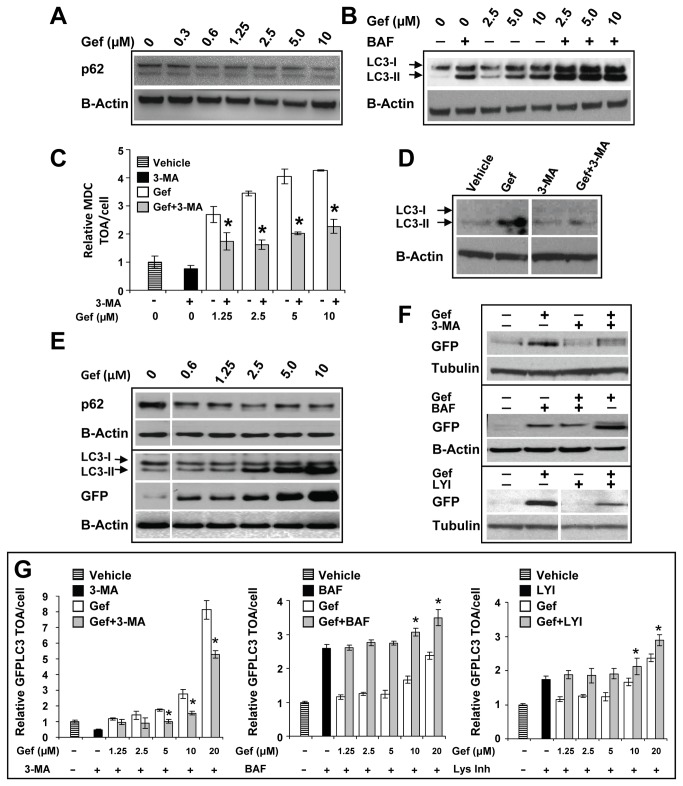
Gefitinib induces autophagic flux.(A - D) Autophagic flux assays performed in SKBR3 cells. (A) Western blot analysis of p62 expression in lysates derived from cells treated for 3 h with vehicle (0 µM gefitinib) or increasing concentrations of gefitinib (Gef) (B) Western blot analysis of LC3 levels in lysates derived from cells treated for 3 h with increasing concentrations of gefitinib in the absence or presence of 5 nM bafilomycin A1 (BAF). (C) HCA of TOA in cells treated for 72 h with increasing concentrations of gefitinib in the absence or presence of 10 mM 3-MA added for the last 3 h of treatment. The results are normalized to the vehicle control expressed as 1. Each bar represents the mean±SD from 3 replicate wells. Asterisks indicate statistically significant differences (p<0.05) between cells treated with gefitinib or 3-MA alone and cells treated with 3-MA in the presence of gefitinib. The results shown are representative of two experiments. (D) Western blot analysis of LC3-I and LC3-II levels in lysates derived from cells treated for 24 h with vehicle, 5 µM gefitinib, 5 mM 3-MA and the combination of gefitinib and 3-MA at the corresponding concentrations. Representative blots in (A), (B) and (D) are shown. (E - G) Autophagic flux assays performed in MCF7-GFPLC3 cells. (E) Western blot analysis of autophagic markers in lysates derived from cells treated for 18 h with increasing concentrations of gefitinib. Cleaved GFP is marked as GFP. (F) Western blot analysis of cleaved GFP levels in lysates derived from cells treated with vehicle or 10 µM gefitinib in the absence or presence of 10 mM 3-MA for 3 h (top panel), in the absence or presence of 50 nM bafilomycin A1 (BAF) for 24 h (middle panel), and in the absence or presence of 10 mg/ml lysosomal inhibitors (LYI; pepstatin A and E-64d) added for the last hour of treatment (bottom panel). Tubulin was used as loading control. Representative blots in (E) and (F) are shown. (G) HCA data showing the average GFPLC3 TOA/cell in MCF7-GFPLC3 cells treated for 3 h with increasing concentrations of gefitinib in the absence or presence of indicated autophagy inhibitors added for the last hour of treatment. The results are normalized to vehicle control expressed as 1. Each data point represents the mean±SD from 3 replicate wells and the results shown are representative of two experiments. 3-MA was used at 5 mM, bafilomycin A1 (BAF) was used at 5 nM and LYI were used at 10 µg/ml. Asterisks indicate statistically significant differences (p<0.05) between cells treated with gefitinib or autophagy inhibitors alone and cells treated with autophagy inhibitors in the presence of gefitinib.